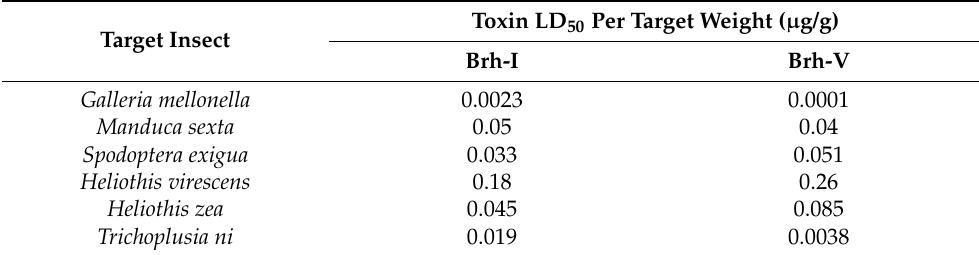
Table 4. LD50s of two Habrobracon hebetor venom proteins against various target insects (Source: data from